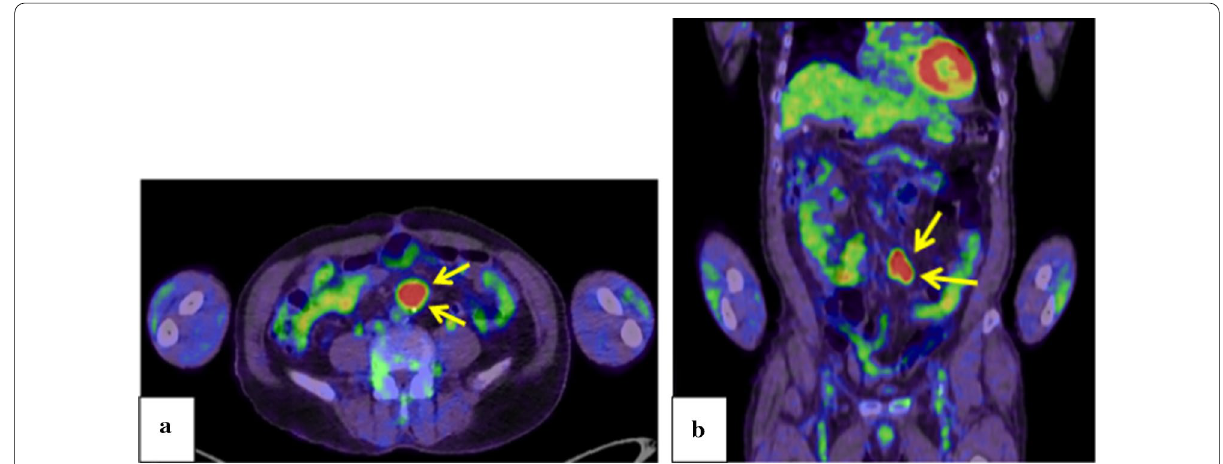
Fig. 7 a, b PET revealed FDG accumulated only into the para-aortic lymph